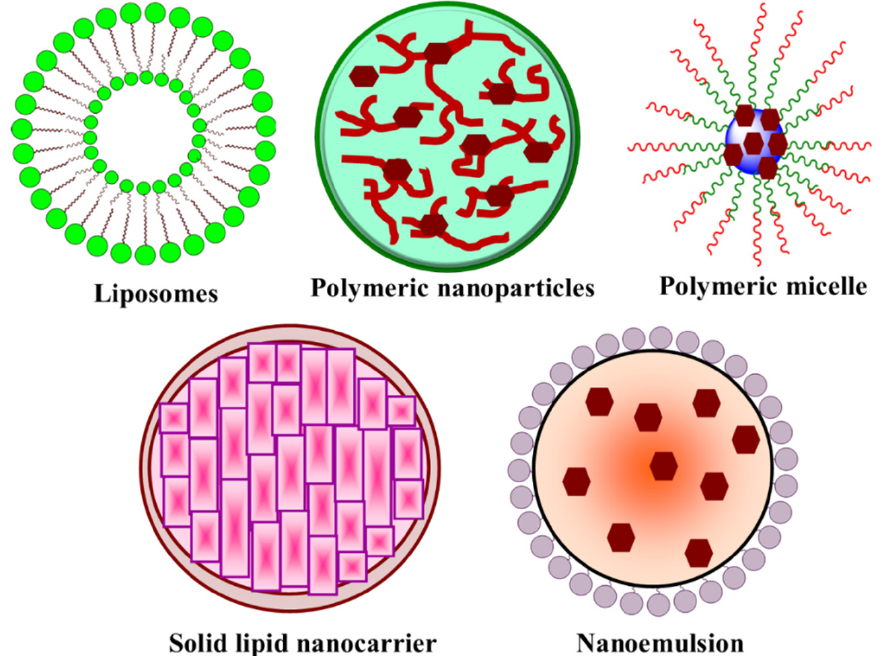
Figure 4. Showing various nanocarriers used for drug delivery in lung cancer.